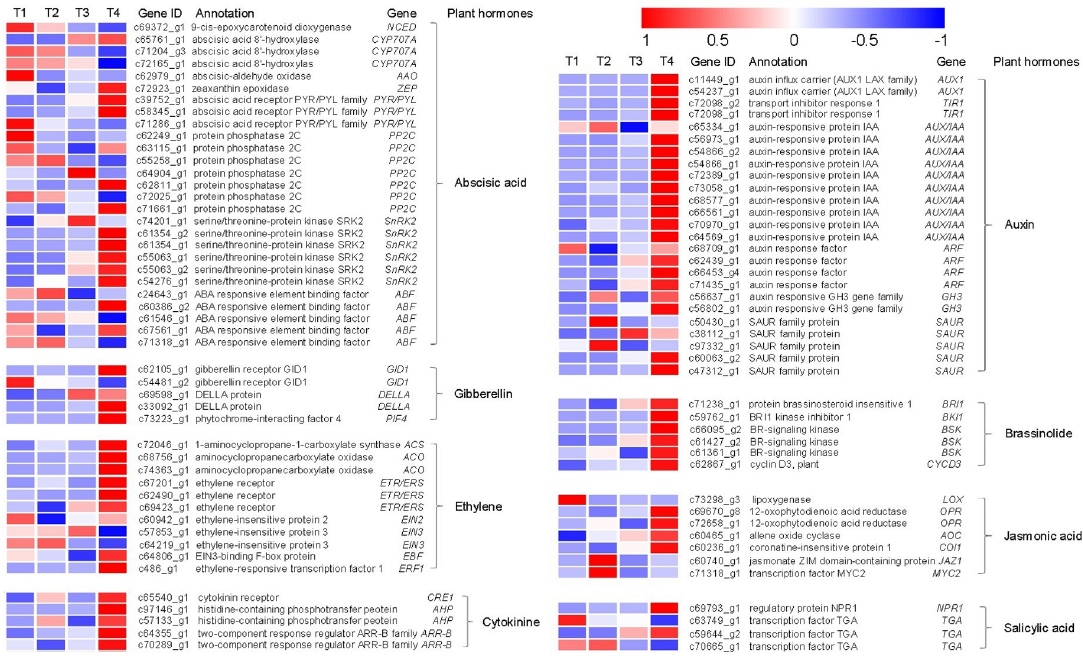
Fig 3. Heatmap of the expressed genes assigned to hormone mentalism and signal transduction pathway in the four transcriptomes, T1, T2, T3, T4. Dry seed (T1); imbibition seed (T2); the radicle breakthrough seed coat (T3); the germ break out (T4).